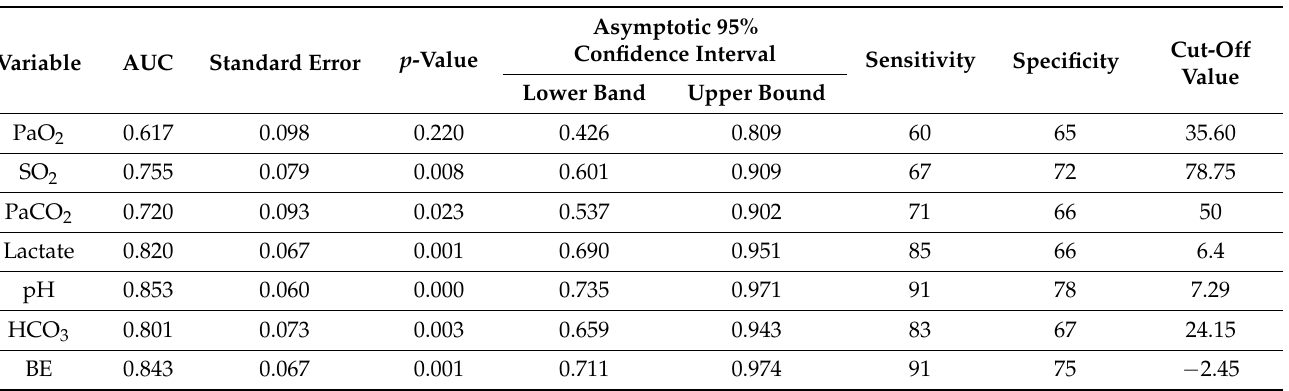
Table 6. The area under the curve (AUC), standard error, confidence interval (95%), optimum cut-off values, respective sensitivity, and specificity of mortality prediction in nonsurvivor calves.